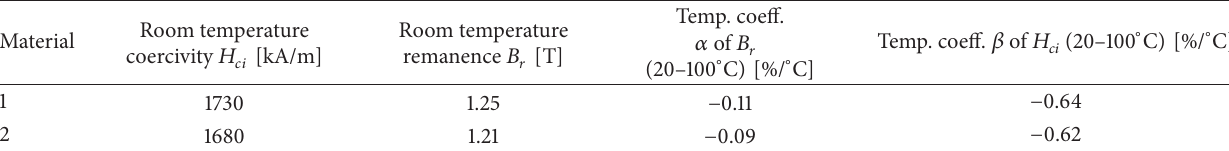
Table 1: Properties of the tested